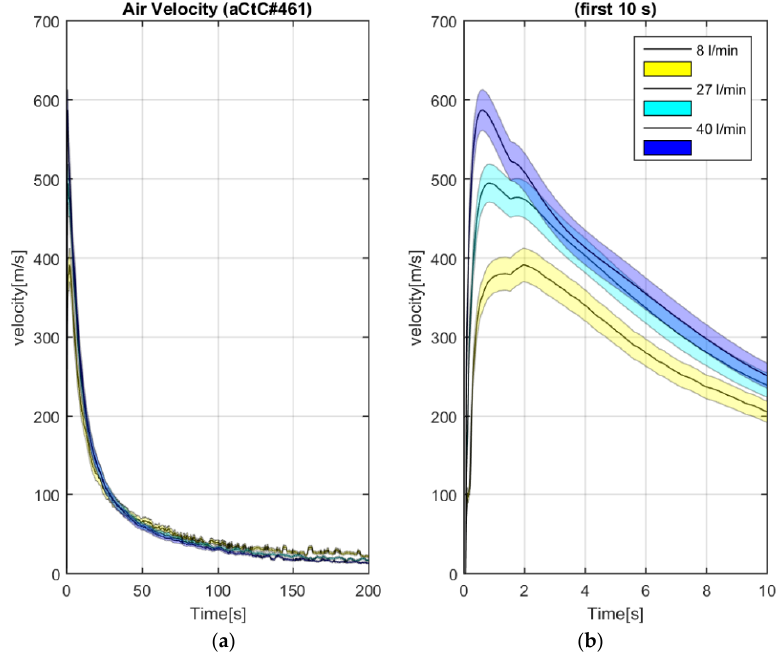
Figure 11. ( a ) Description of the velocities variation during the whole experiments. ( b ) A detail of the velocities variation in the first 10 s.